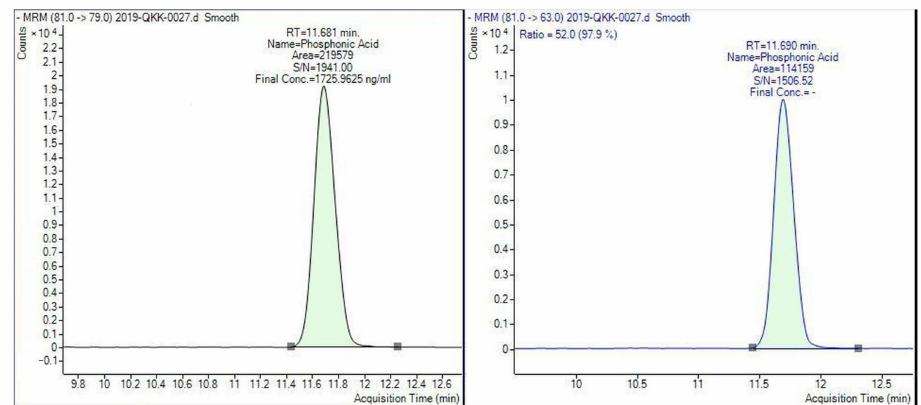
Figure 3. LC-MS/MS chromatograms of the extract of the cherry sample containing phosphonic acid (calculated as fosetyl-Al) at a level of 1.73 mg kg −